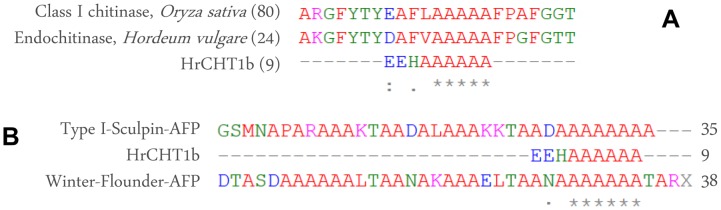
N-terminal sequence of HrCHT1b.Alignment of N-terminal HrCHT1b sequence with other chitinases (A) and antifreeze proteins (B).